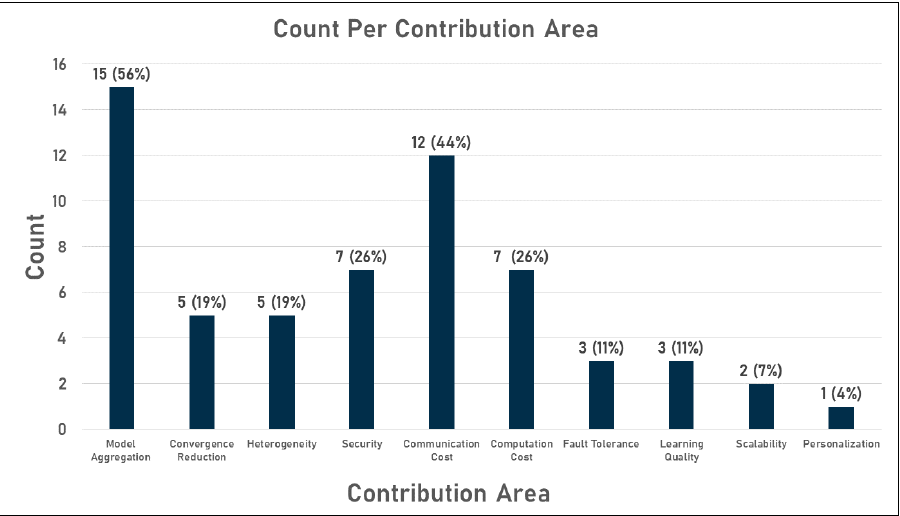
Figure 7. Aggregation algorithms count per contribution